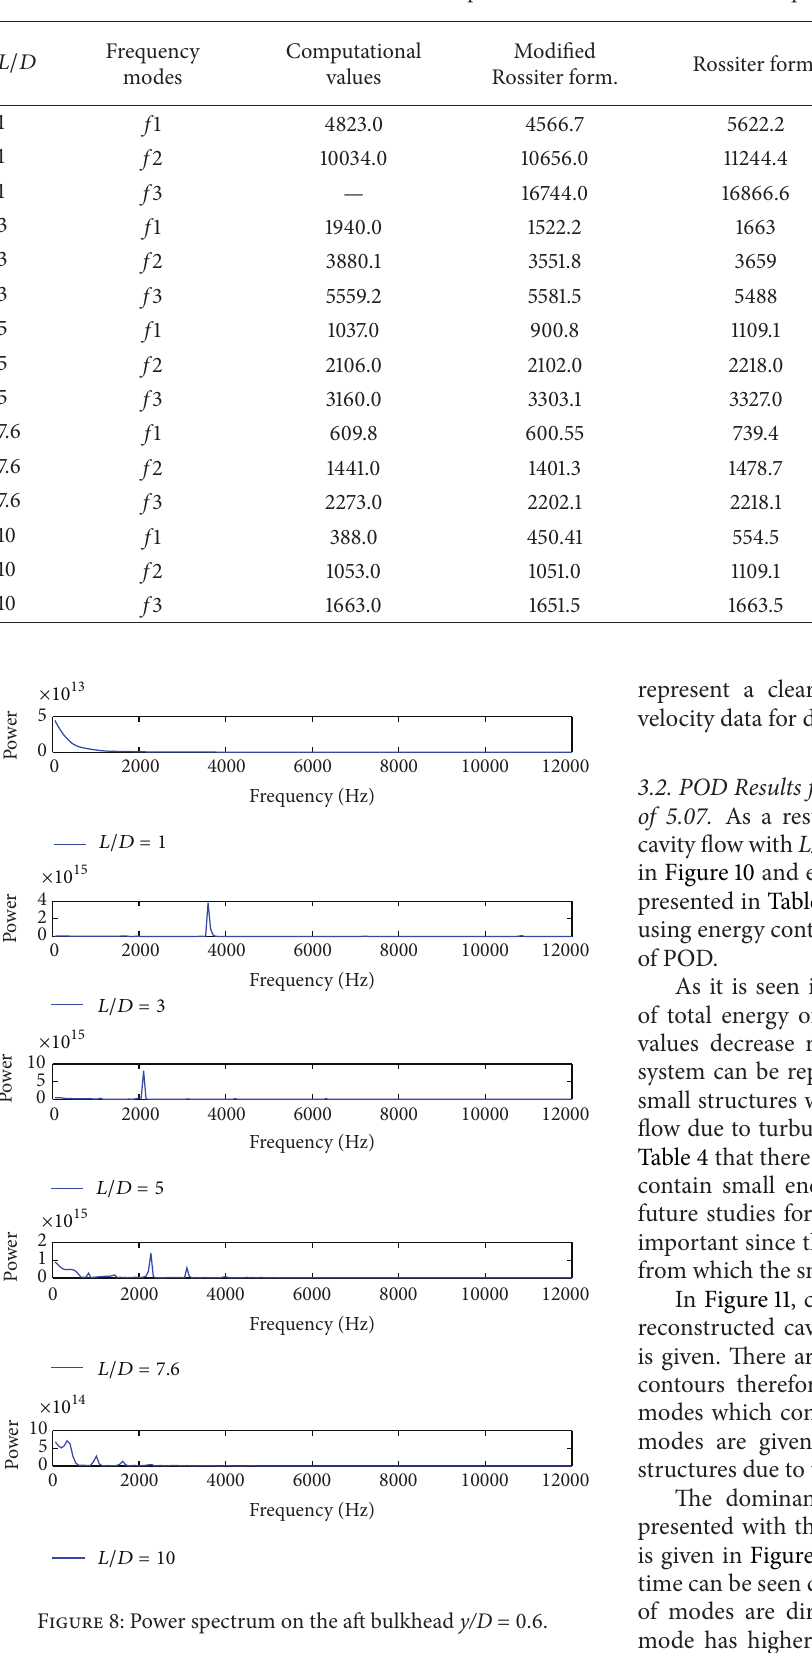
Table 3: Experimental and calculated mode frequencies.